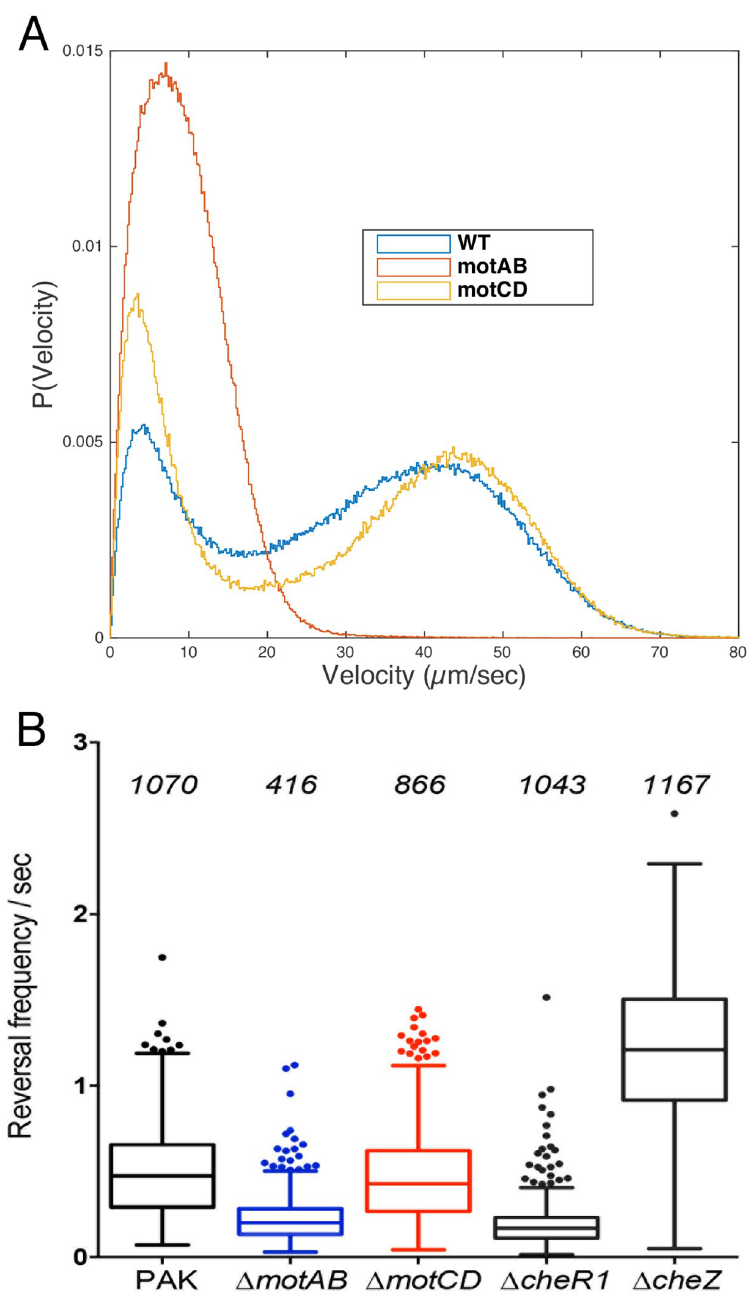
Fig 9. Δ motAB and Δ motCD bacteria show distinct distributions of velocity (A) and reversal frequency (B) during liquid swimming. Cells of each genotype were imaged under dark-field microscopy at 30 fps. Image analysis was carried out as described in Methods using a custom MATLAB code. In (B), boxplots span 1 st and 3 rd quartiles with a line at the median. The number of cells tracked is shown above each sample in panel B; data from these tracked cells was also used to generate the histogram in panel A, in which the y-axis shows the probability of observing a given velocity.